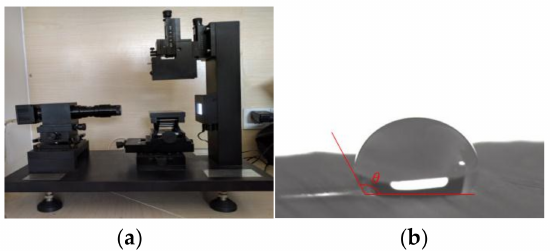
Figure 8. Sketch map of contact angle measurement. ( a ) The contact angle measuring instrument; ( b ) static contact angle. Table 5. Range and average of reference value θ r produced by respective HCs, and the comparison of the recognition results of recognition model with test value θ t of the contact angle